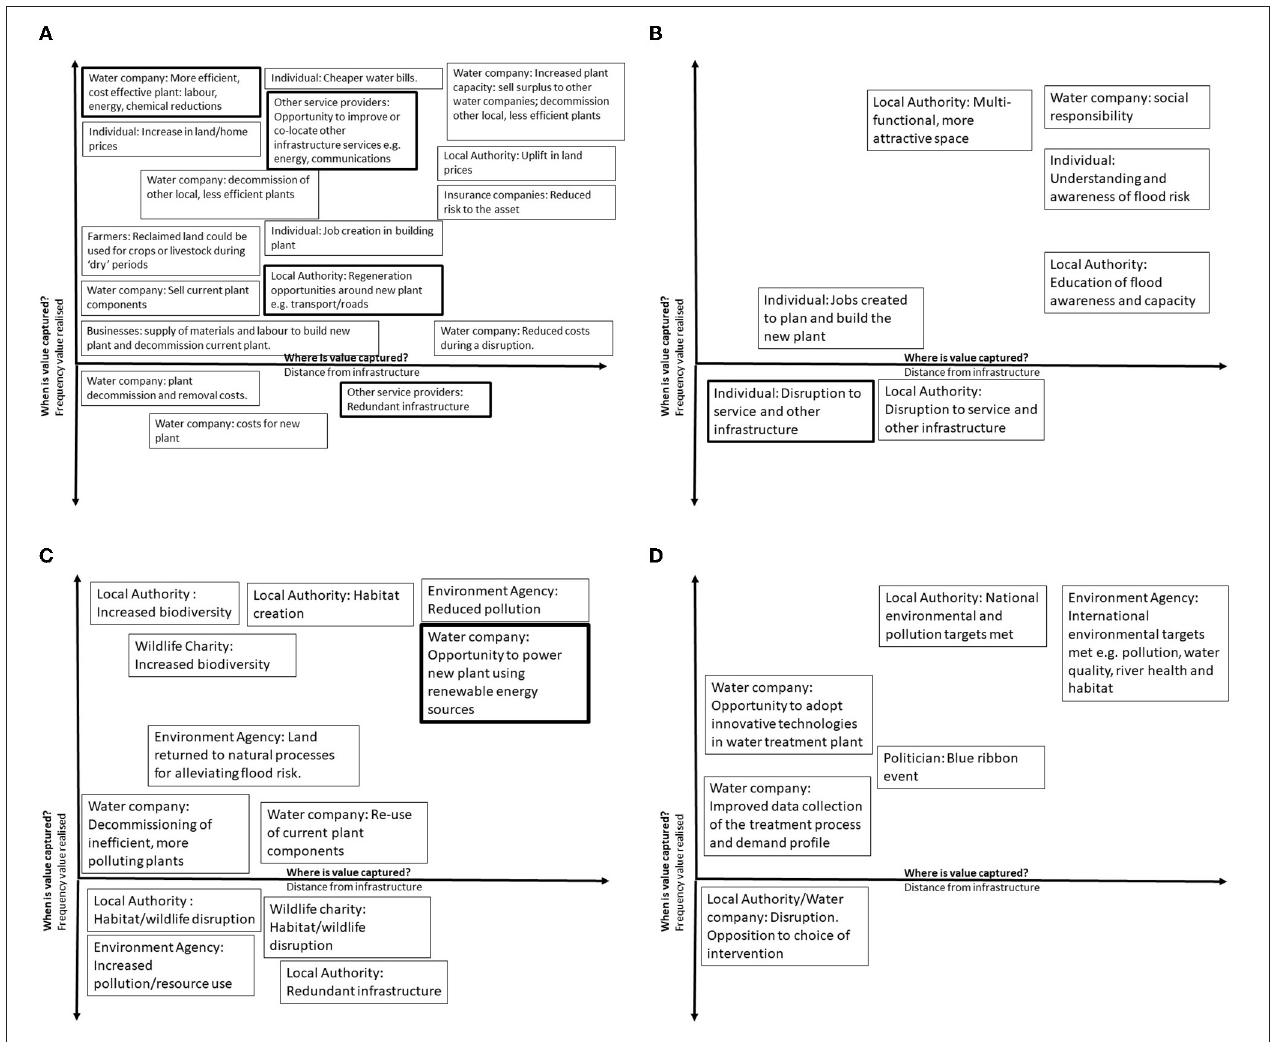
FIGURE 3 | Value maps for adaptation of existing infrastructure to deliver greater resilience for (A) economic values (B) social values (C) environmental values (D) political and technical values. Emboldened boxes indicate interdependencies with other sectors.